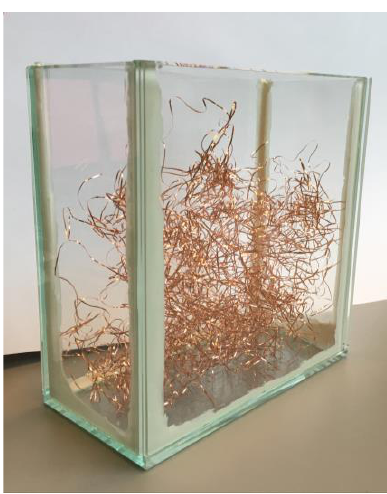
Fig. 2. PCM container with fine copper wires as heat transfer enhancer element.